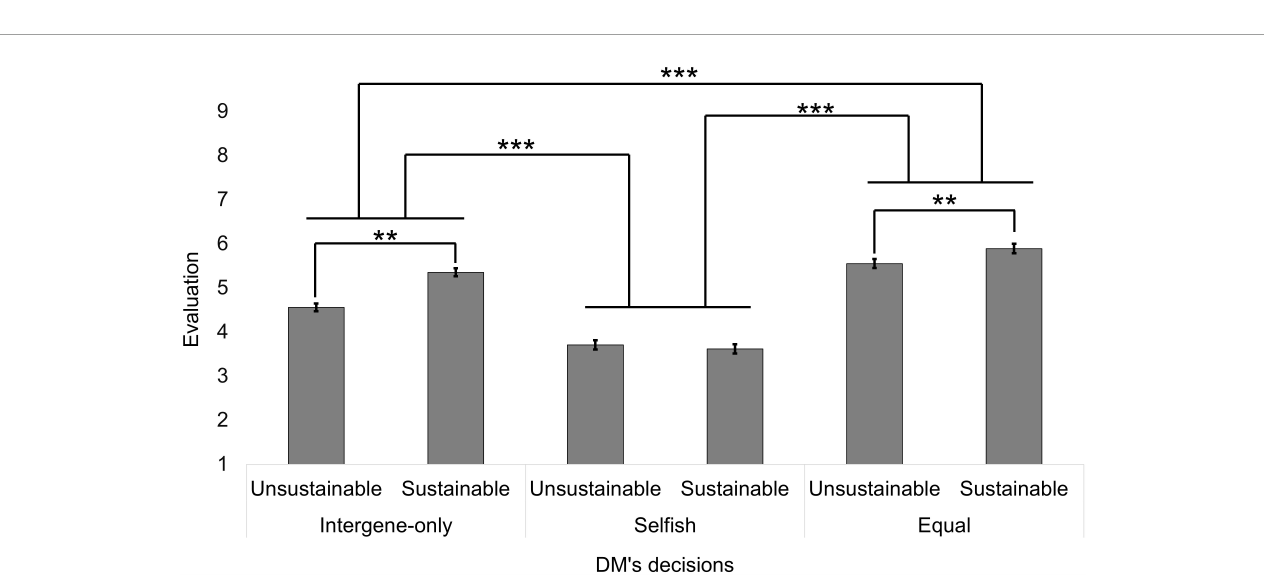
FIGURE4 The evaluations in Study 2. The error bars represented the standard errors. Different from the main text, sample means were shown. The asterisks indicate statistical significance based on the ANCOVA and the simple main effect analysis of the sub-sample (Holm-corrected). ** p < 0.01, *** p <